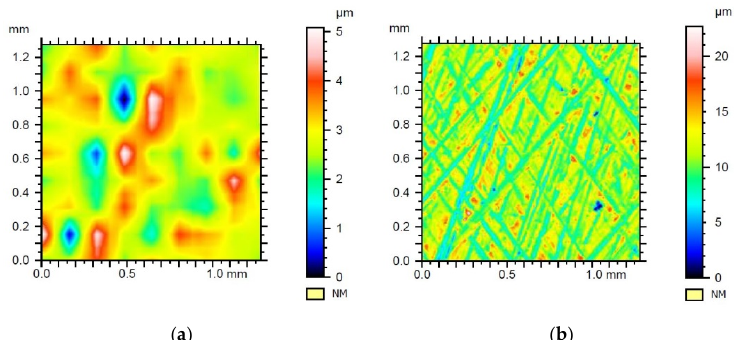
wavelet of the 3rd row with the 3rd level of filtration—( a ) waviness, ( b ) roughness.